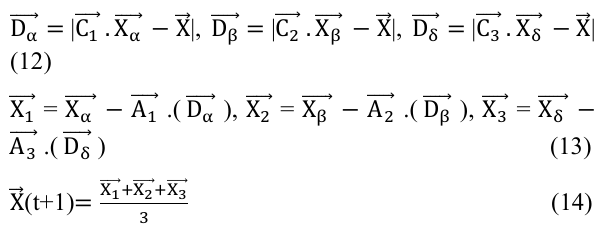
Figure 4. Positions updation in